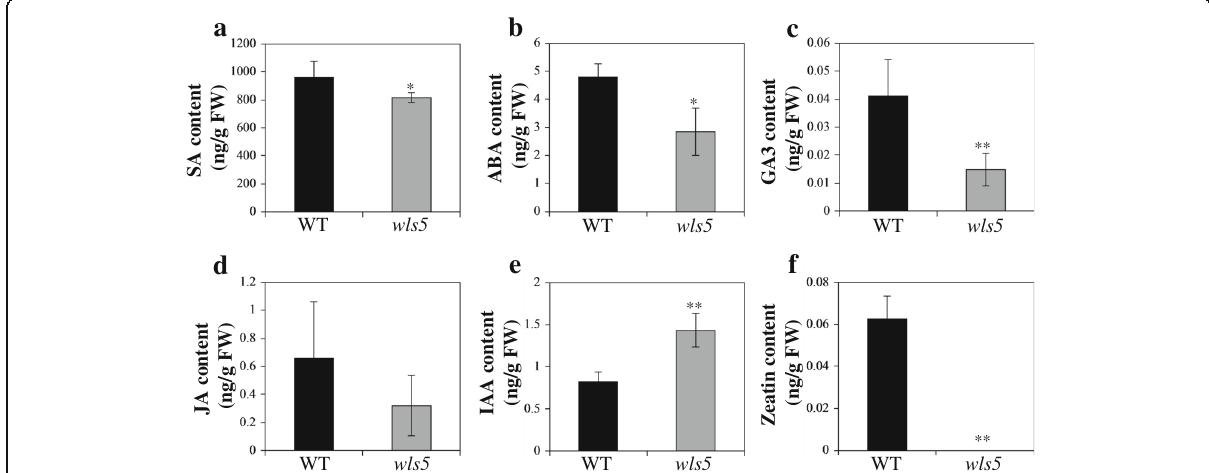
Fig. 7 Comparison of endogenous hormone contents between wild-type (WT) and wls5 plants. SA ( a ), ABA ( b ), GA3 ( c ), JA ( d ), IAA ( e ) and zeatin ( f ) content in leaves of WT ( ‘ 93 – 11 ’ ) and wls5 plants at tillering stage. Means ± SD of three independent replicates. * P <0.05; ** P <0.01 (Student ’ s t